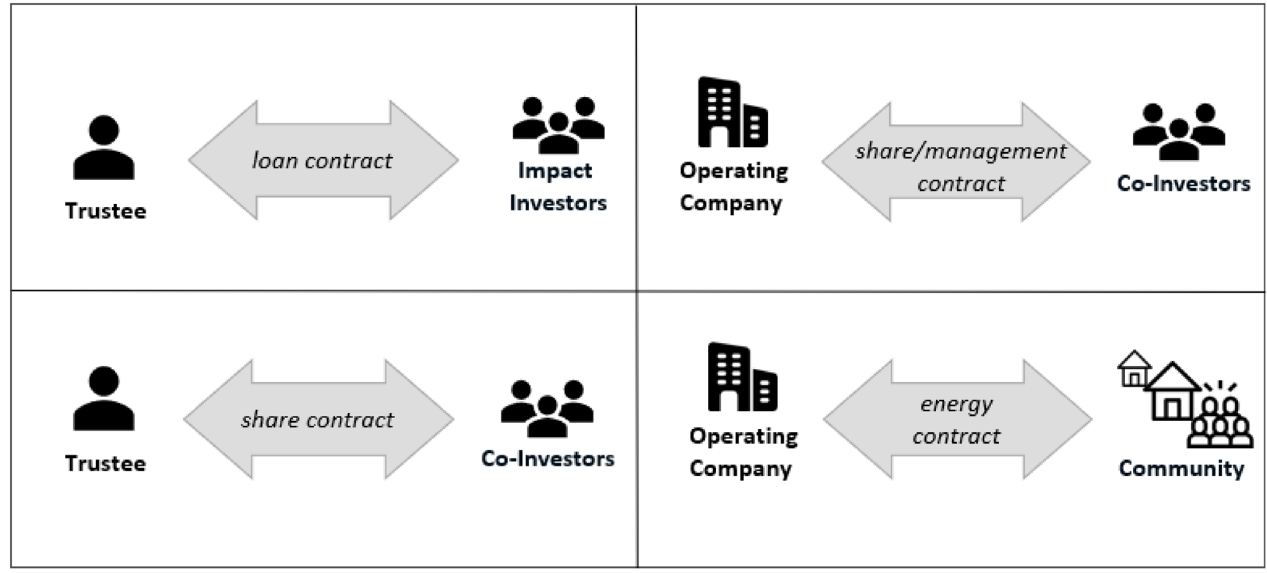
Fig. 2. Possibilities of individual smart